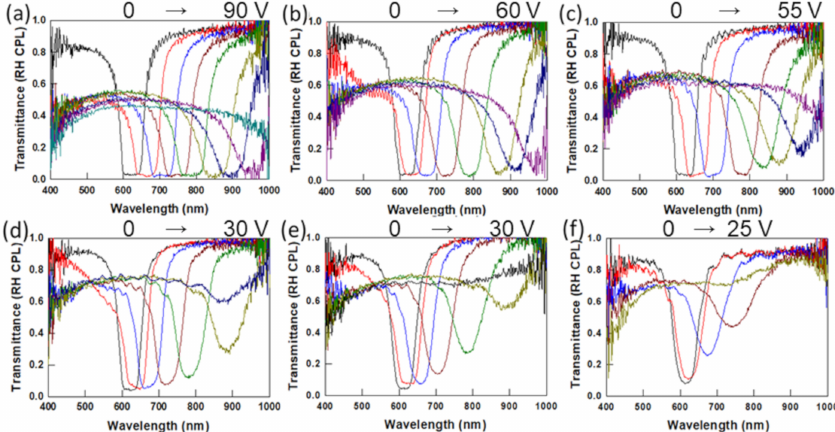
Figure 3. Transmission spectra of negative ∆ ε PSCLCs with various cell thicknesses and DC voltages in the ranges shown above each graph: ( a ) 14.1 ± 0.3 µ m thickness, 0 V to 90 V DC, ( b ) 10.3 ± 0.3 µ m, 0 V to 60 V DC, ( c ) 7.6 ± 0.2 µ m, 0 V to 55 V DC, ( d ) 4.9 ± 0.2 µ m, 0 V to 30 V DC, ( e ) 3.6 ± 0.2 µ m, 0 V to 30 V DC and ( f ) 2.5 ± 0.2 µ m, 0 V to 25 V DC. Composition: 0.4 wt% I-369, 6 wt% SL04151, 5